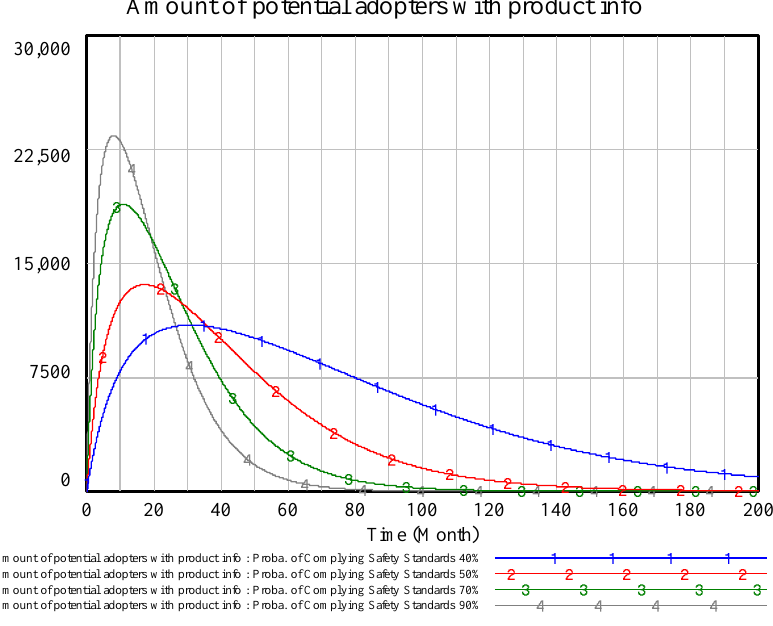
Figure 8. Sensitivity of probability of complying with safety standards on number of potential adopters with product info.